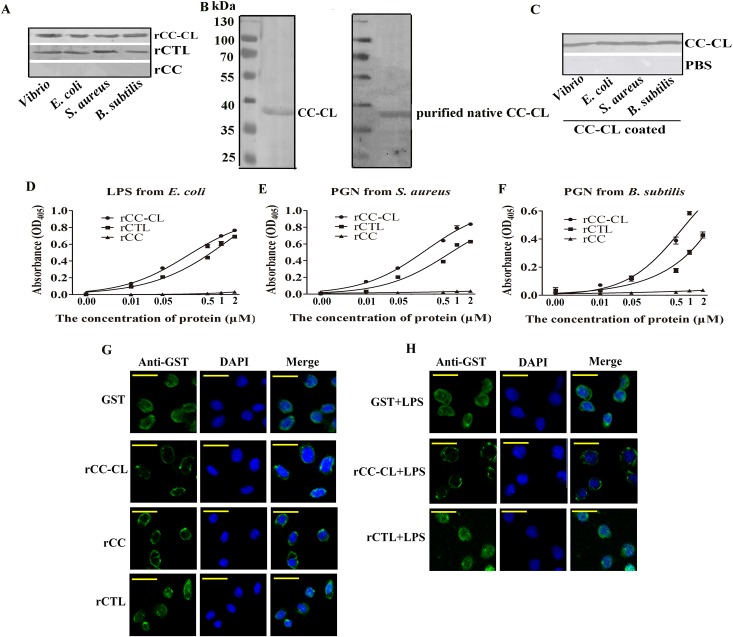
MjCC-CL binds to bacteria and to the hemocyte surface.(A) Western blotting was used to analyze the binding activity of rMjCC-CL, the rCTLD of MjCC-CL and the rCCD of MjCC-CL with different bacteria. (B) The left panel showed the molecular masses of native MjCC-L as detected with MjCC-CL polyclonal antibody by western blot. In the right panel, Native MjCC-CL was purified from kuruma shrimp intestine with CNBr-activated Sepharose 4B by coupling the antibody from MjCC-CL. (C) Western blotting was used to analyze the binding activity of native MjCC-CL with different bacteria. (D-F) An ELISA was performed to detect the binding activity of rMjCC-CL, the rCTLD and the rCCD to LPS from E. coli and PGN from S. aureus or B. subtilis. (G) Immunocytochemical analysis was performed to test the binding of rMjCC-CL and rCC to the hemocytes surface. (H) Immunocytochemical assay was performed to detect if rMjCC-CL can cross-link LPS to the hemocyte surface.